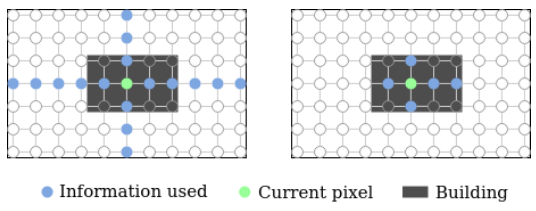
Figure 2. Illustration of classic SGM (left) and our implementation (right) with 4 directions. History of previous pixels along the path is discarded when a building edge is